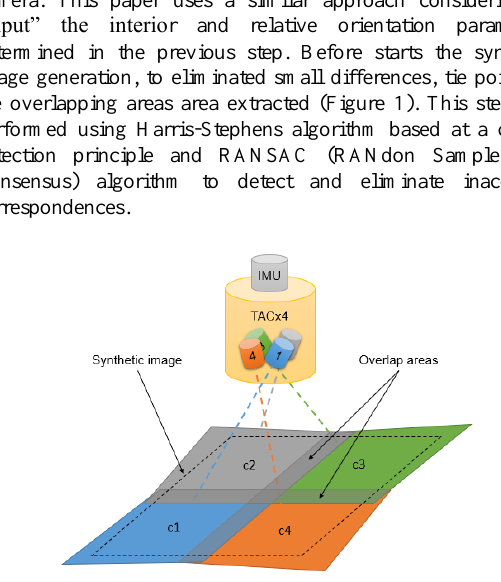
Figure 1. Imaging system scheme with overlap areas. (Ercolin Filho, et al.,